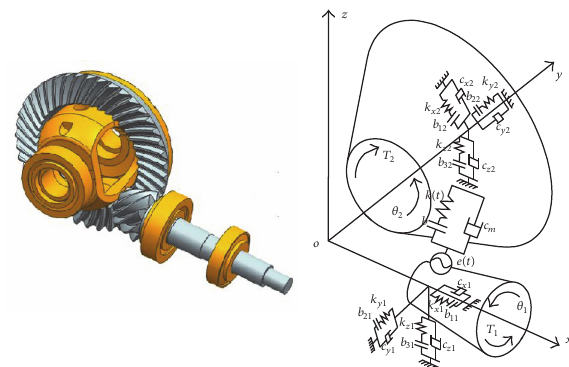
Figure 1: Dynamic model of a spiral bevel gear